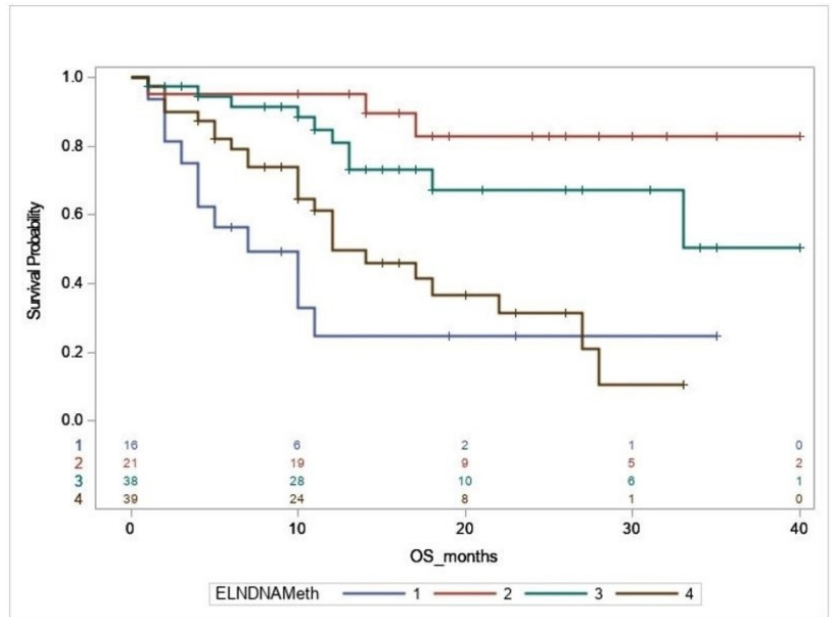
Figure 2. Overall survival (OS) rates in ELN favorable group with and without DNA-MR, ELN intermediate, and ELN adverse group. Kaplan–Meier curves for OS in ELN favorable with DMRGM ( Blue line: 1, median OS: 7 months), ELN favorable without DMRGM ( Red line: 2, median OS: Not reached), ELN intermediate ( Green line: 3, median OS: Not reached) and ELN adverse group ( Brown line: 4, median OS: 12 months). The OS of the ELN favorable with DMRGM was significantly shorter than that of the favorable group without DMRGM ( p = 0.0001) or the ELN intermediate group ( p = 0.0078). The median OS of ELN favorable group with DMRGM was not significantly different from that of ELN adverse group ( p =